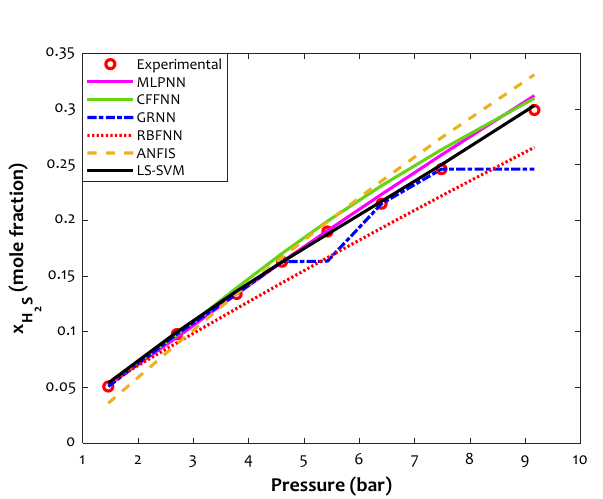
Figure 5. The prediction ability of the developed models for H 2 S solubility in [BMIM][Tf 2 N] (T = 343.15